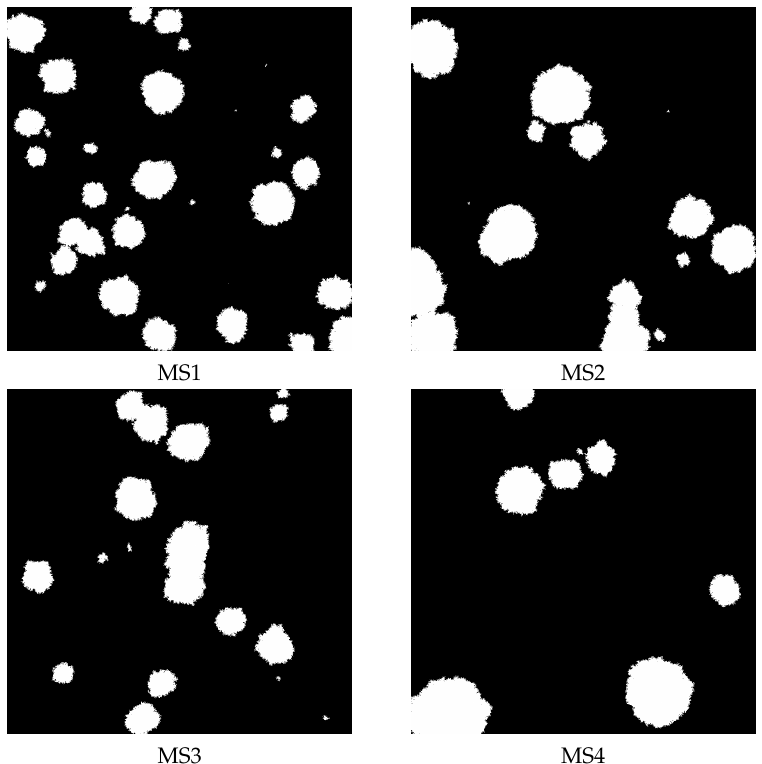
Figure 3. The artificial membrane structures with different structural parameters: MS1 ( ρ = 0.85, d f = 1.9687, ∆ D = 0.7102); MS2 ( ρ = 0.85, d f = 1.9664, ∆ D = 1.1809); MS3 ( ρ = 0.9, d f = 1.9792,